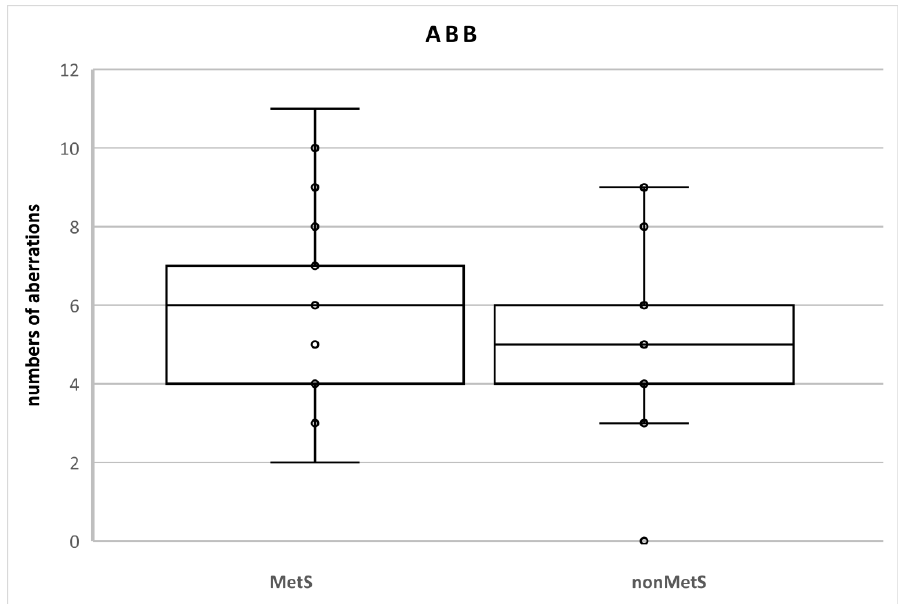
Figure 2. Numbers of chromosomal aberrations in MetS and nonMetS patients. Legend: The horizontal line in the boxes indicates the position of the median, the ends of the boxes define the 25th and 75th percentiles, and error bars mark the 10th and 90th percentiles. Y is an outlier. Table 4. Individual analysis, number of persons with aberration.